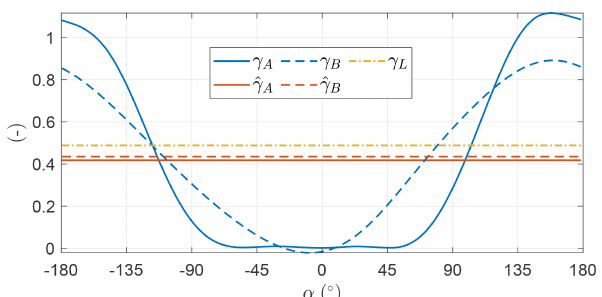
Figure 26. Optimal γ as a function of the angular position.